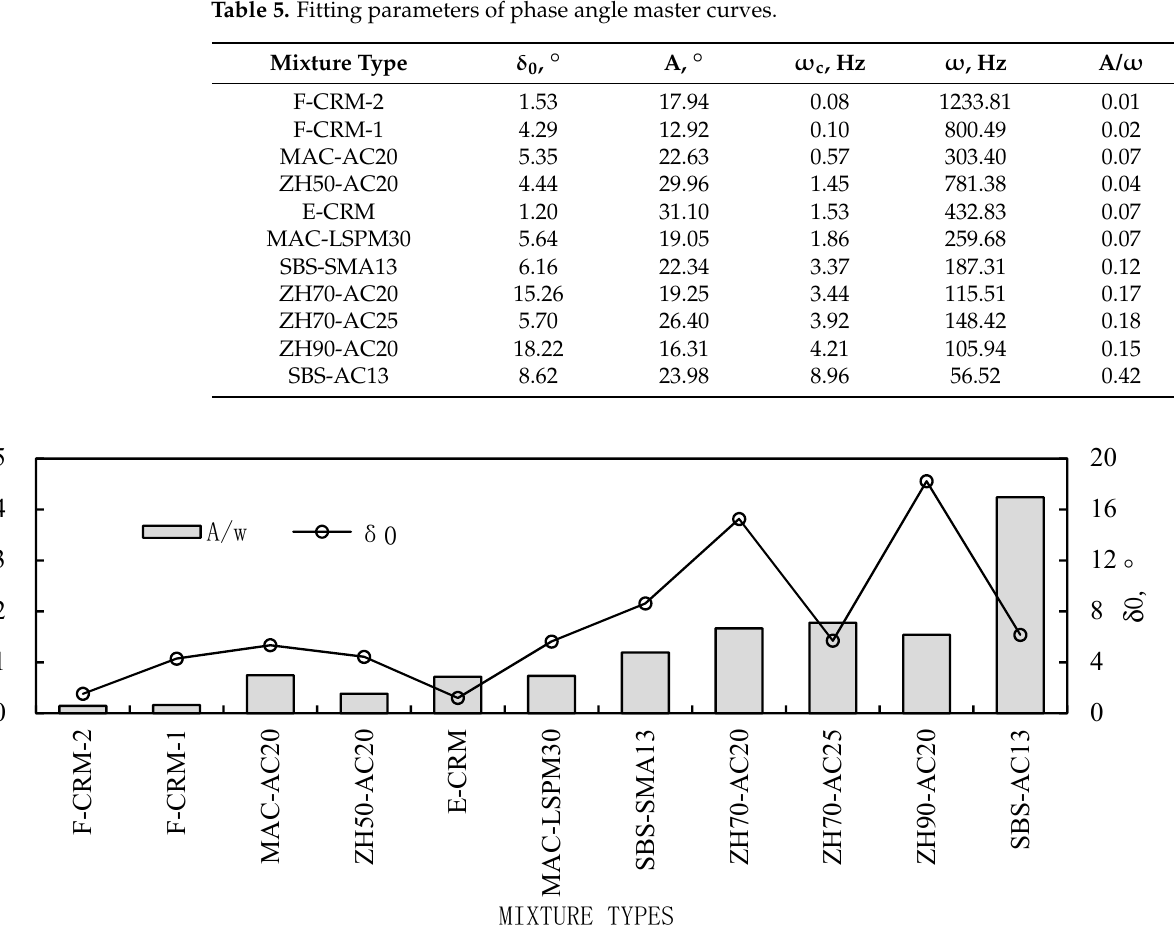
Table 5. Fitting parameters of phase angle master curves.